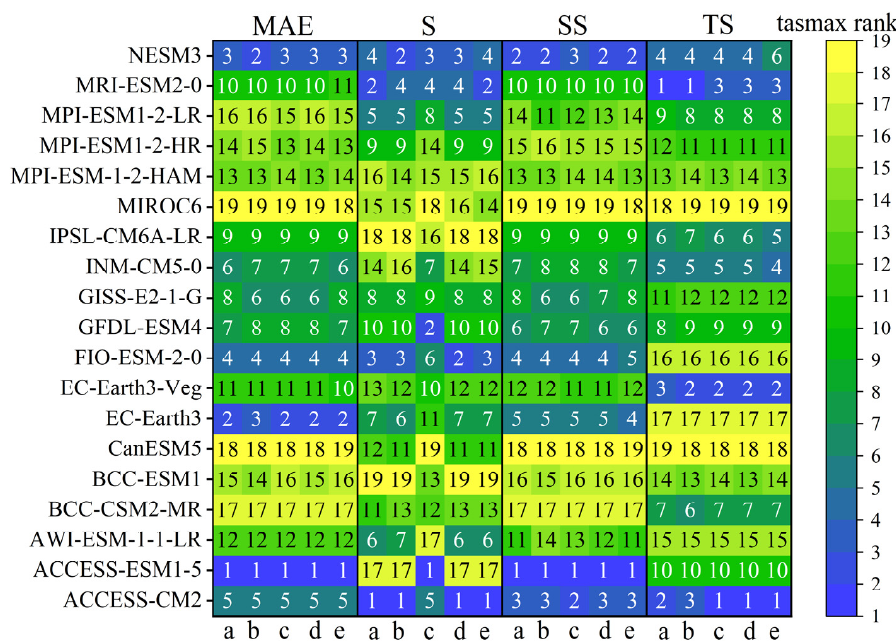
Figure 4. Fitting performance ranking of 19 climate models simulating tasmax monthly series of the Yellow River Basin from 1995 to 2014 under different interpolation methods and evaluation metrics. a, b, c, d, and e under each evaluation method are the evaluation rankings of the five interpolation methods: BI, IDW, kriging, NNI, and spline, respectively. The higher the ranking, the higher the model’s fitting accuracy.